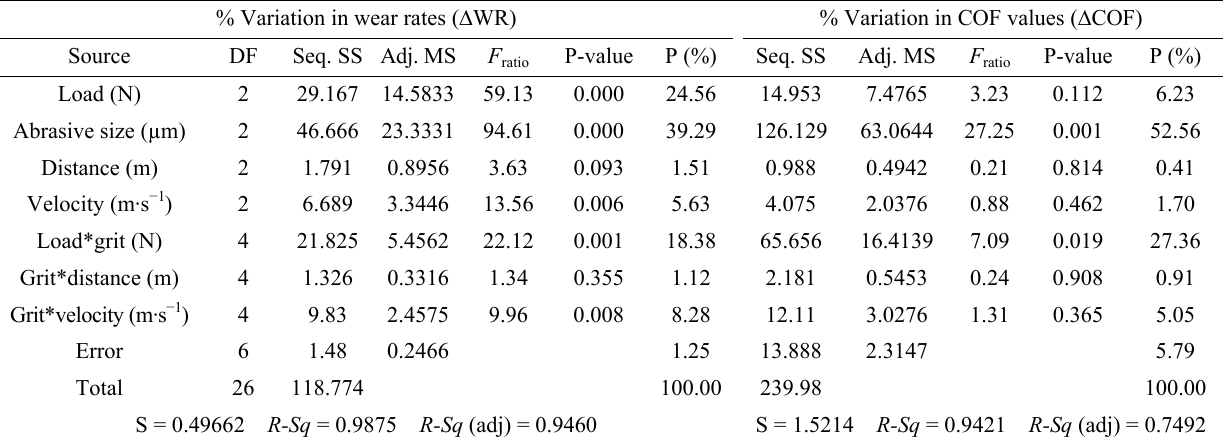
Table 5 ANOVA tables based on S/N ratios of outputs. % Variation in wear rates (  WR) % Variation in COF values ( 